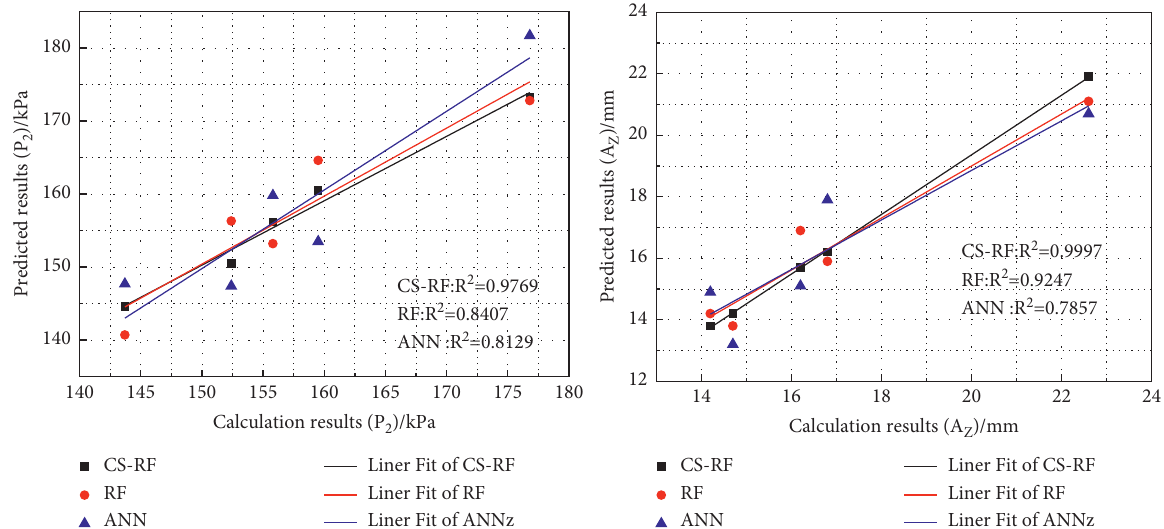
Figure 10: Prediction performance of different methods for displacement and stress.